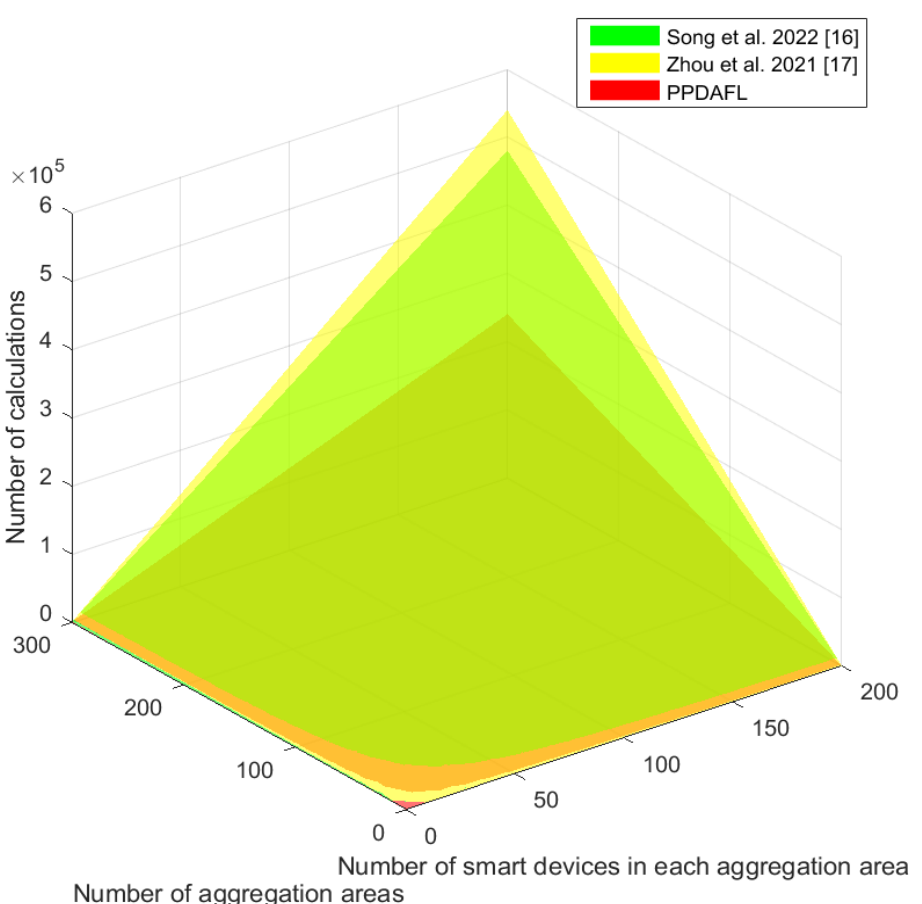
Figure 3. Comparison of computational cost [16,17].